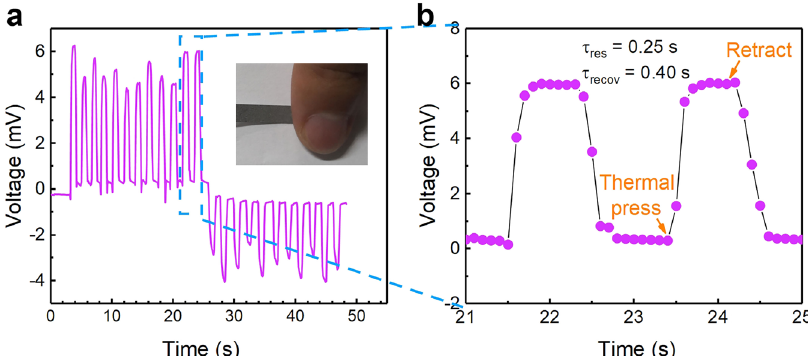
Fig. 4 Sensor response of the modi fi ed paper with a fi nger touch. a Voltage response with a fi nger touch at a frequency of approximately 1 s − 1 . The insert is the illustration of the fi nger touch test. b Enlarged view of the blue dashed box in ( a